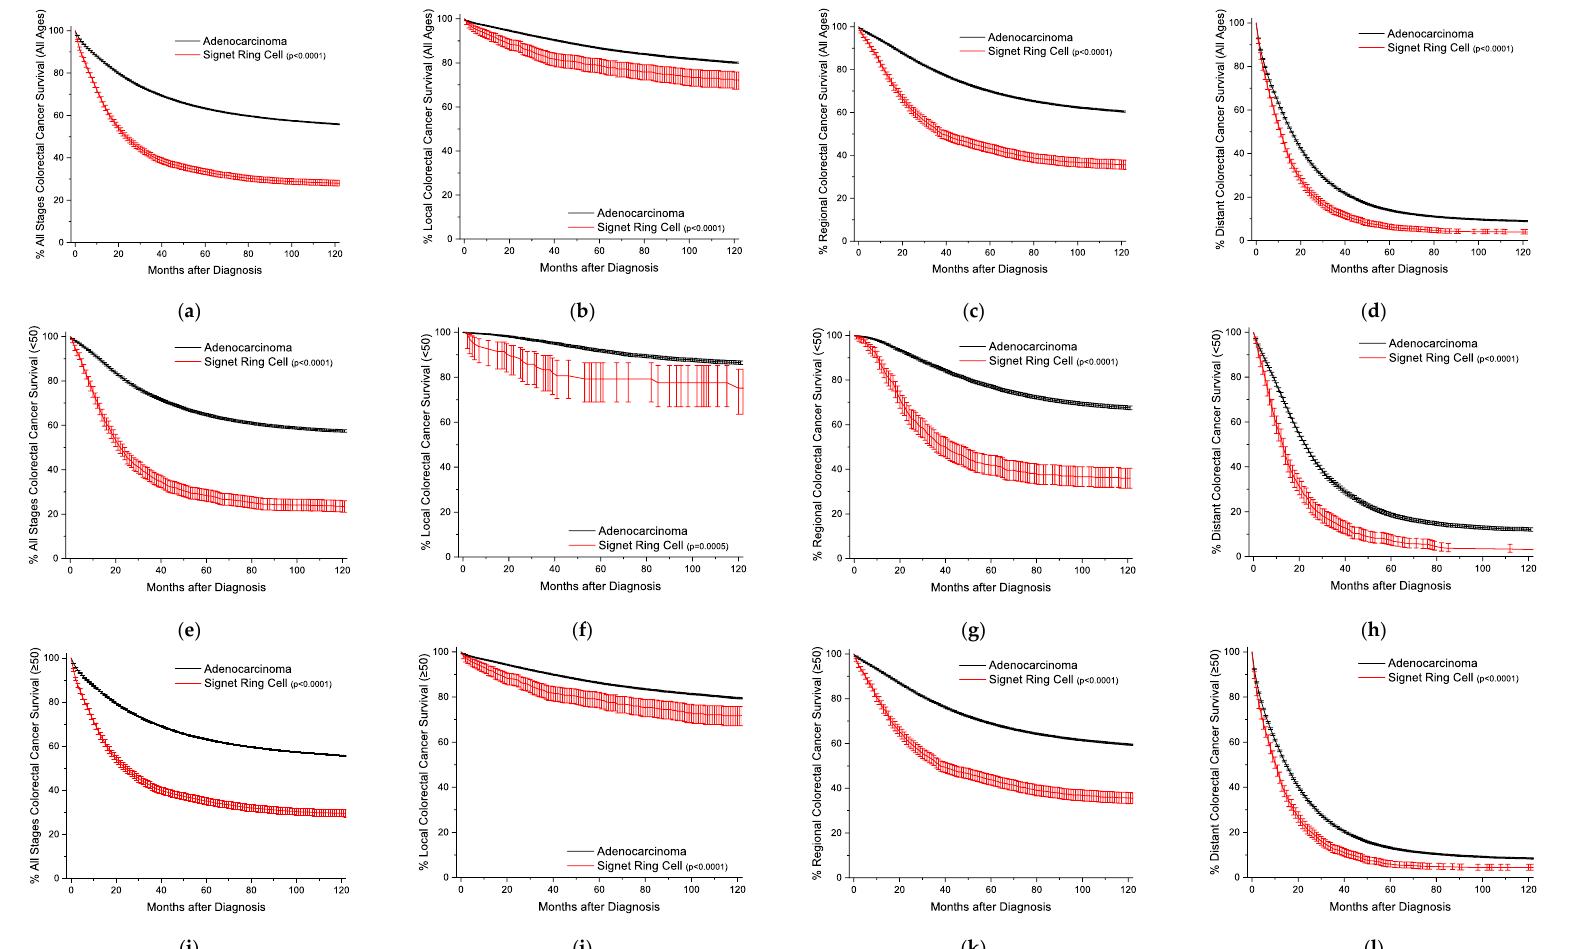
Figure 2. Kaplan-Meier survival curves for colorectal cancer. All survivor functions are shown with 95% confidence intervals. ( a ) All ages, all stages. ( b ) All ages, local disease. ( c ) All ages, regional disease. ( d ) All ages, distant disease. ( e ) Age < 50, all stages. ( f ) Age < 50, local disease. ( g ) Age < 50, regional disease. ( h ) Age < 50, distant disease. ( i ) Age ≥ 50, all stages. ( j ) Age ≥ 50, local disease. ( k ) Age ≥ 50, regional disease. ( l ) Age ≥ 50, distant disease. p -values between curves by log-rank